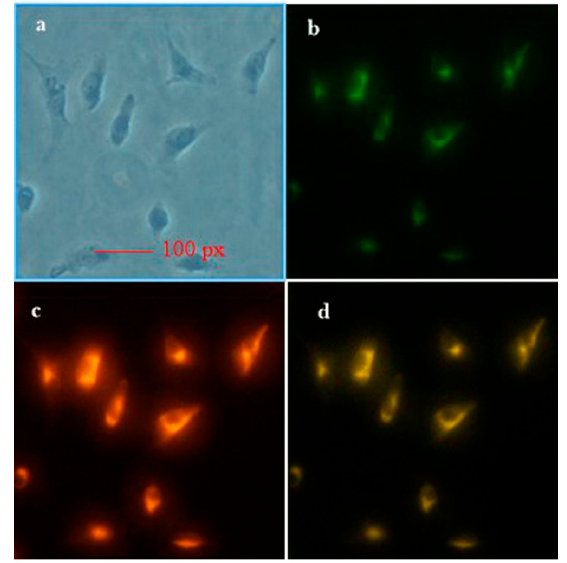
Figure 3. Fluorescent images. MDA-MB-231 cells stained with 10 µM PHBT. ( a ) Bright field image of PHBT in cells; ( b ) green fluorescence of PHBT in cells after 30 min of irradiation at 405 nm; ( c ) red fluorescence of PHBT in cells; and ( d ) overlay of (b) and (c).